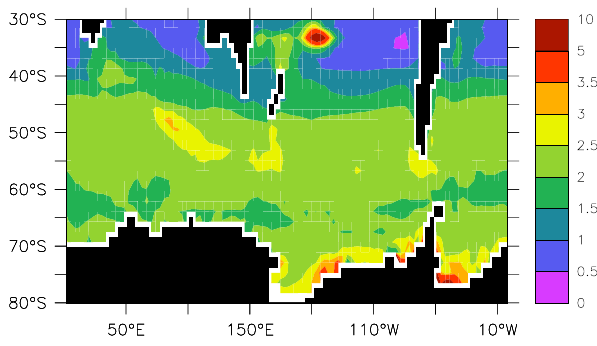
Fig. 1. Ratio of the particulate carbon export across z =125m simu- lated by the fertilization experiment in year 2011 (first year of fer- tilization) and the control experiment in the same